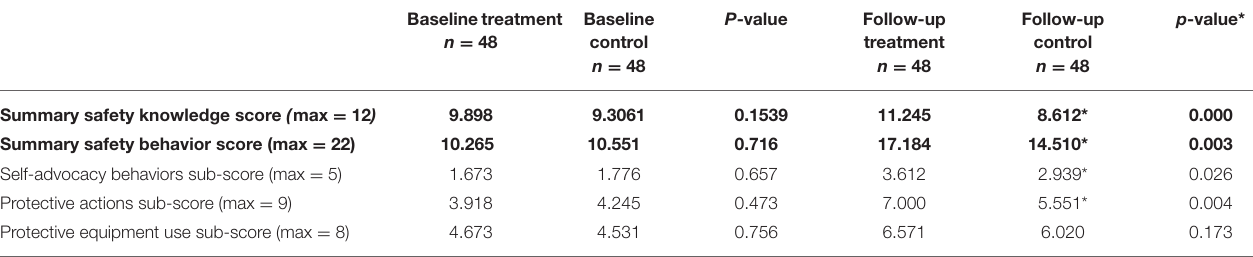
TABLE 4 | Means and changes in preventive occupational behaviors and knowledge scores.